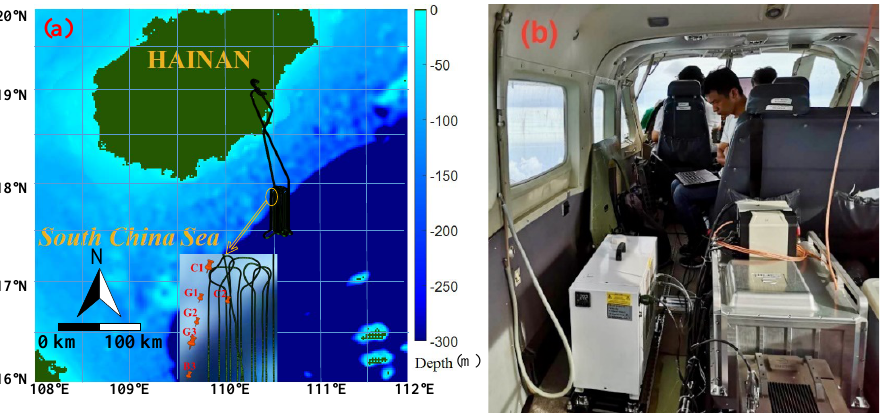
Figure 3. Experiments in the South China Sea. ( a ) Distributed flight track and selected in situ sites; ( b ) photograph of the DWOL system in airborne experiment.